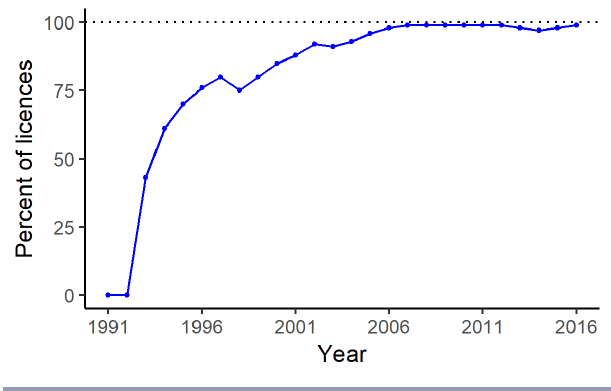
Fig. 1 . The percentage of halibut licences involved in temporary quota transactions each year.